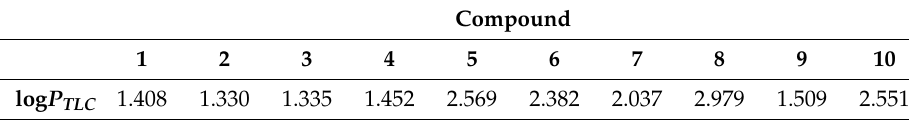
Table 7. The log P TLC values of investigated compounds 1–10